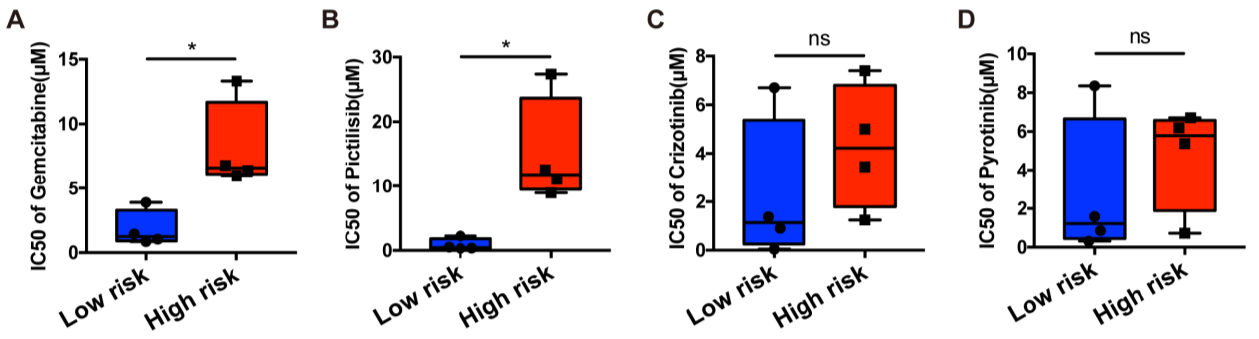
Figure 8. In vitro drug-sensitivity investigations. ( A – D ). The high-risk group tended to show lower sensitivity to drug therapy compared with the low-risk group (ns = non-significant; * = significant at 0.05 levels).